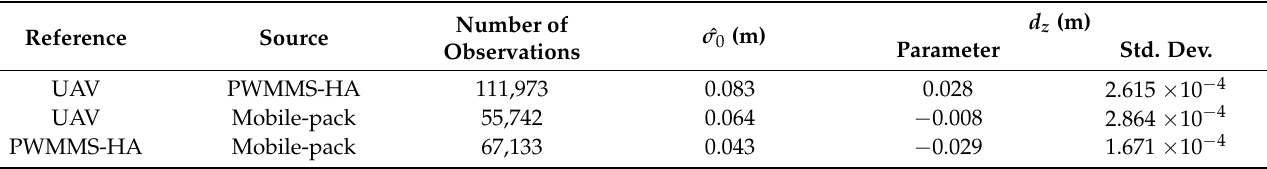
Table 6. Estimated vertical discrepancy ( (cid:1856) (cid:3053) ) and square root of a posteriori variance ( (cid:2026) (cid:2868) (cid:3550) ) using A-1 (UAV), A-2 (PWMMS- HA), and A-3 (Mobile-pack) datasets.